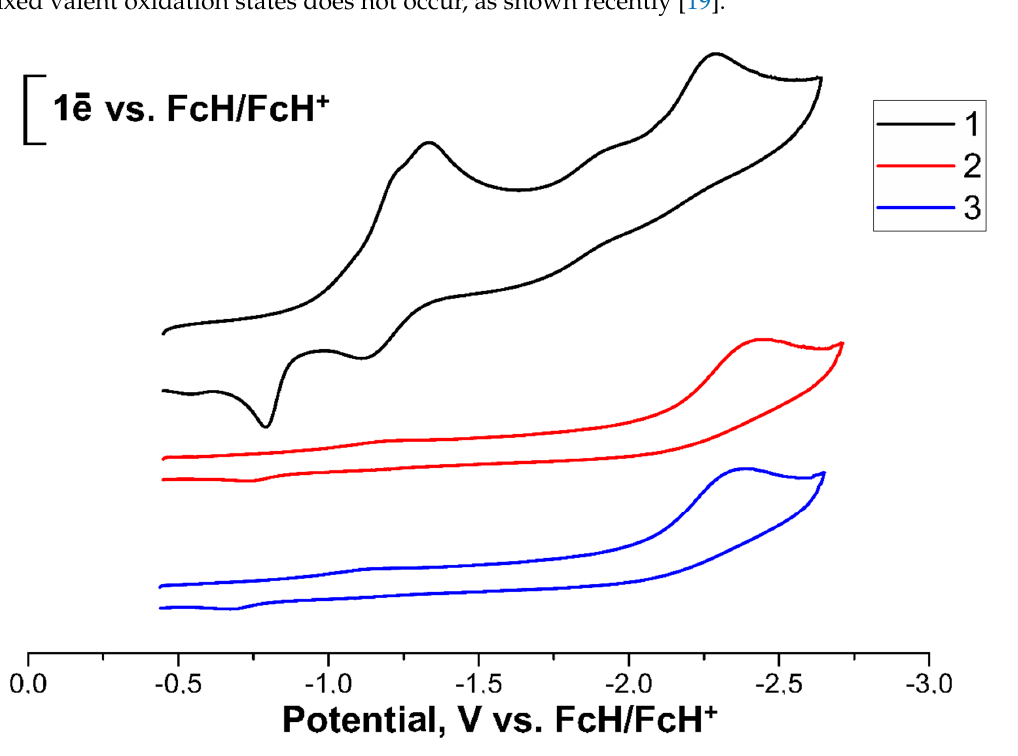
Figure 3. Cyclic voltammograms for reduction of 1–3 . Conditions: 0.5 mM solutions of 1–3 in CH 3 CN, 0.1 M [NBu 4 ][BF 4 ]; working electrode: glassy carbon, 10 mVs − 1 , peak potential in V ref. Ag/AgCl recalculated to FcH/FcH + .